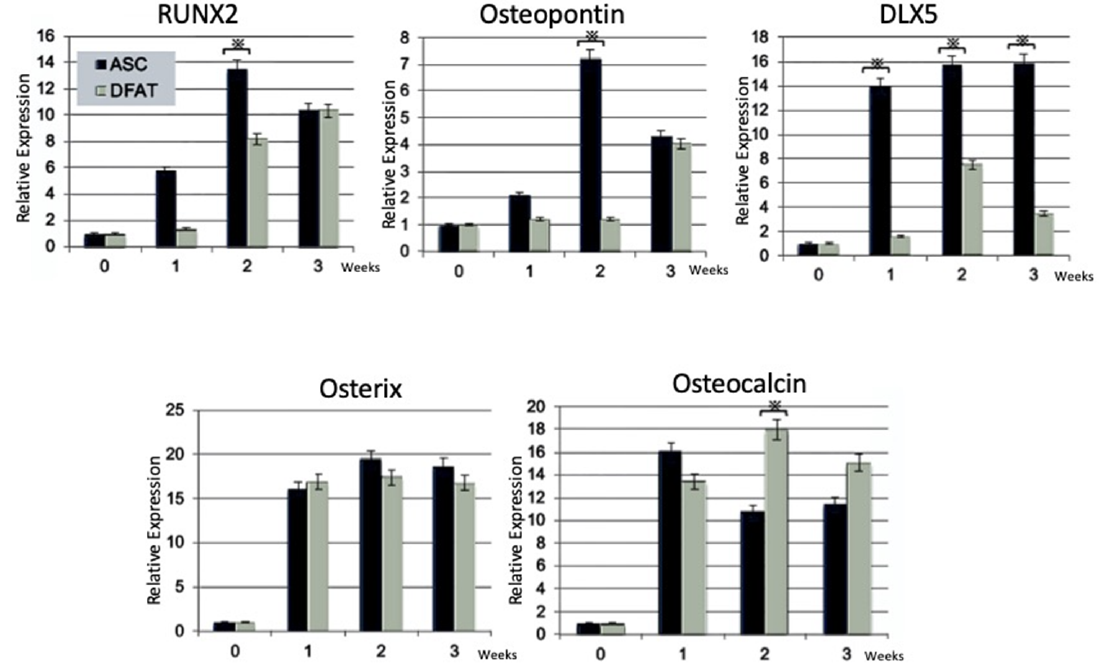
Figure 4. Comparison of osteoblast marker genes (RUNX2, osteopontin, DLX5, osterix, osteocalcin) of DFATs and ASCs as assessed by RT-PCR before (0 weeks) and after osteogenic differentiation culture (1–3 weeks). * p < 0.05